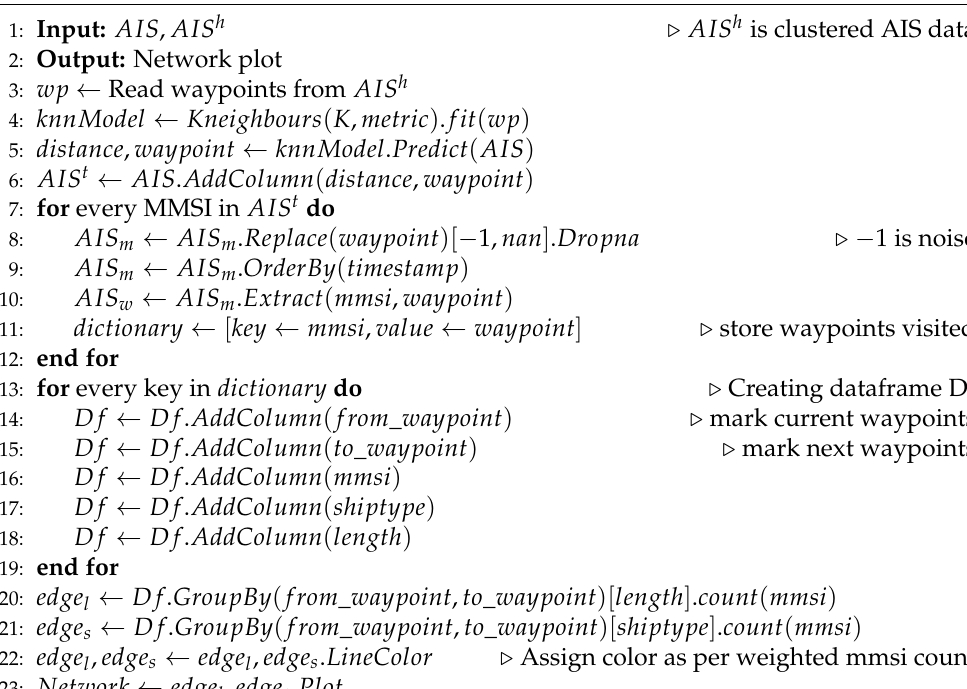
Algorithm A1 . Network Construction